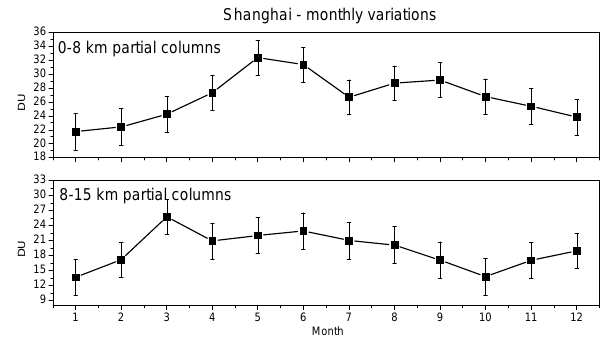
Figure 4. Monthly mean variations of different partial columns (0-8 km column, and 8-15 km column) retrieved from IASI observations over Shanghai in 2008.